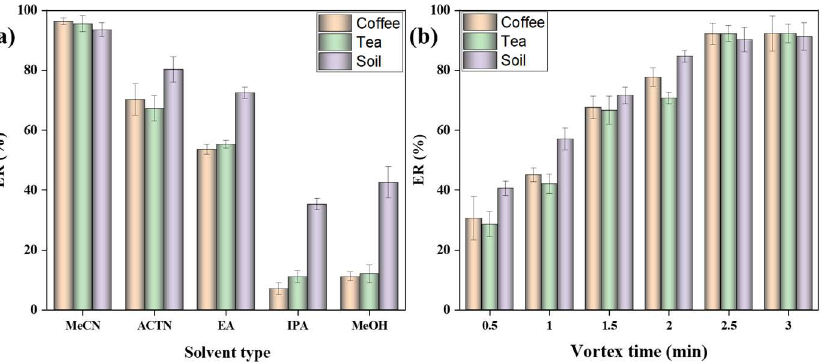
Figure 2. ( a ) Selection of extraction solvent, and ( b ) Selection of extraction time for the extraction of OTA from coffee samples. Extraction conditions: 250 mg sample, 2.0 mL solvent, 2.5 min of vortex extraction, and clean-up under the flow rate of 0.5 mL/min using the 1000 mg MgSO 4 , 75 mg AC and 50 mg C18 with three replicate analyses.